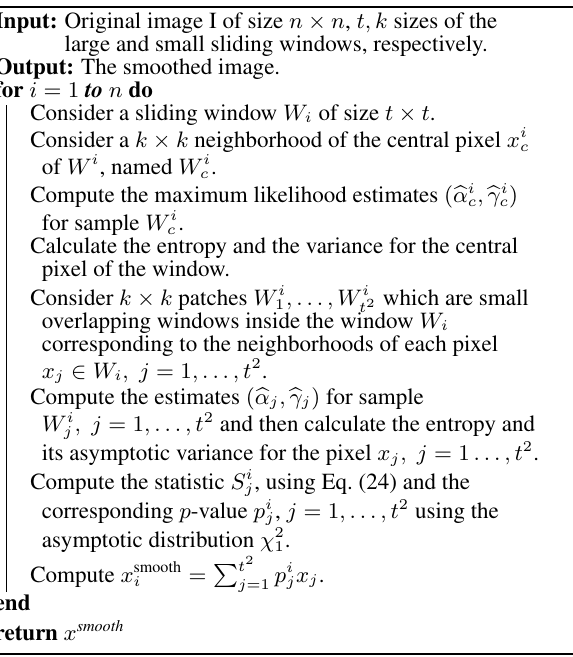
Algorithm 1: Despeckling algorithm.